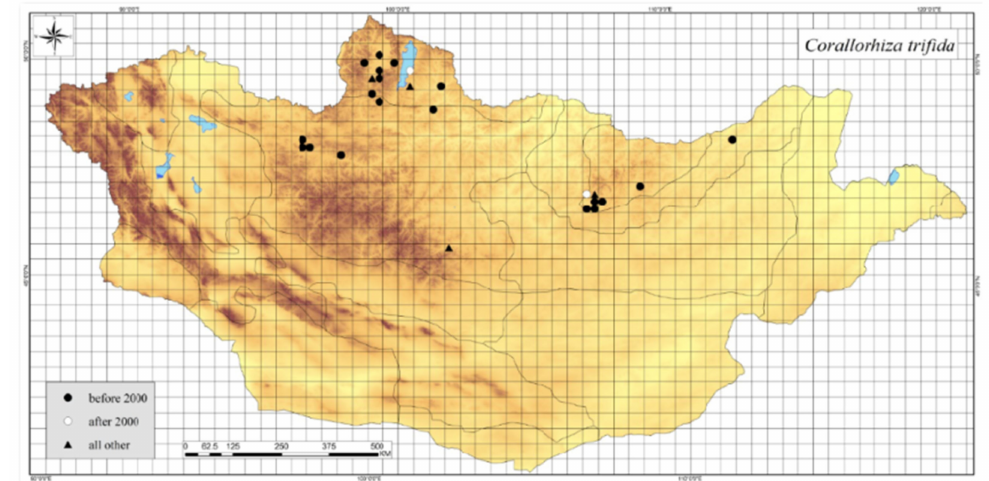
Figure A2. Distribution map of Corallorhiza trifida in